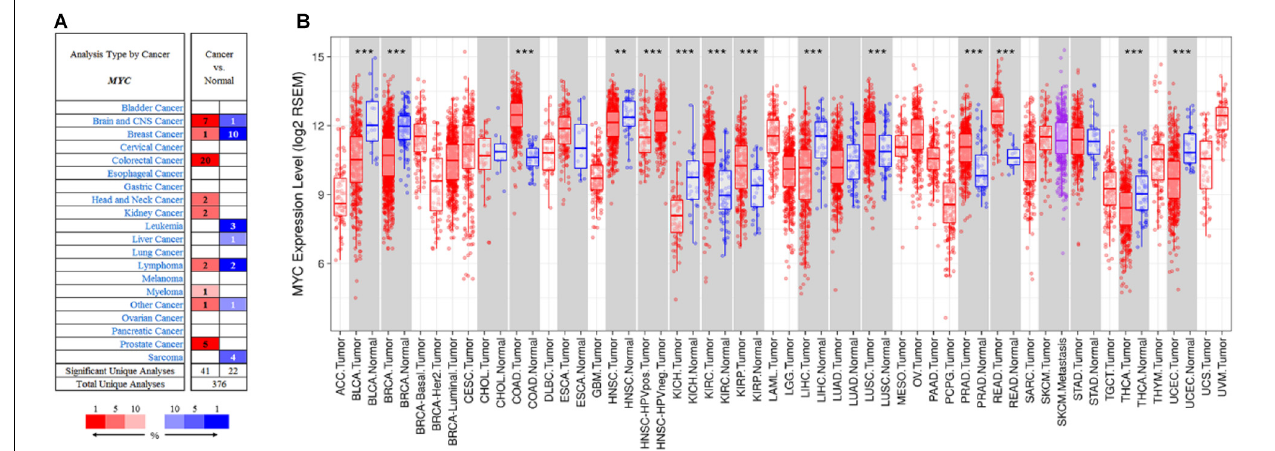
FIGURE 8 | Pan-cancer analysis for MYC. (A) MYC expression in Oncomine database. (B) MYC expression in TIMER database. The cell color in (A) is determined by the best gene rank percentile for the analyses within the cell. Red: tumor. Blue: normal. The box plot colors in (B) indicate tumor and normal expression. Red: